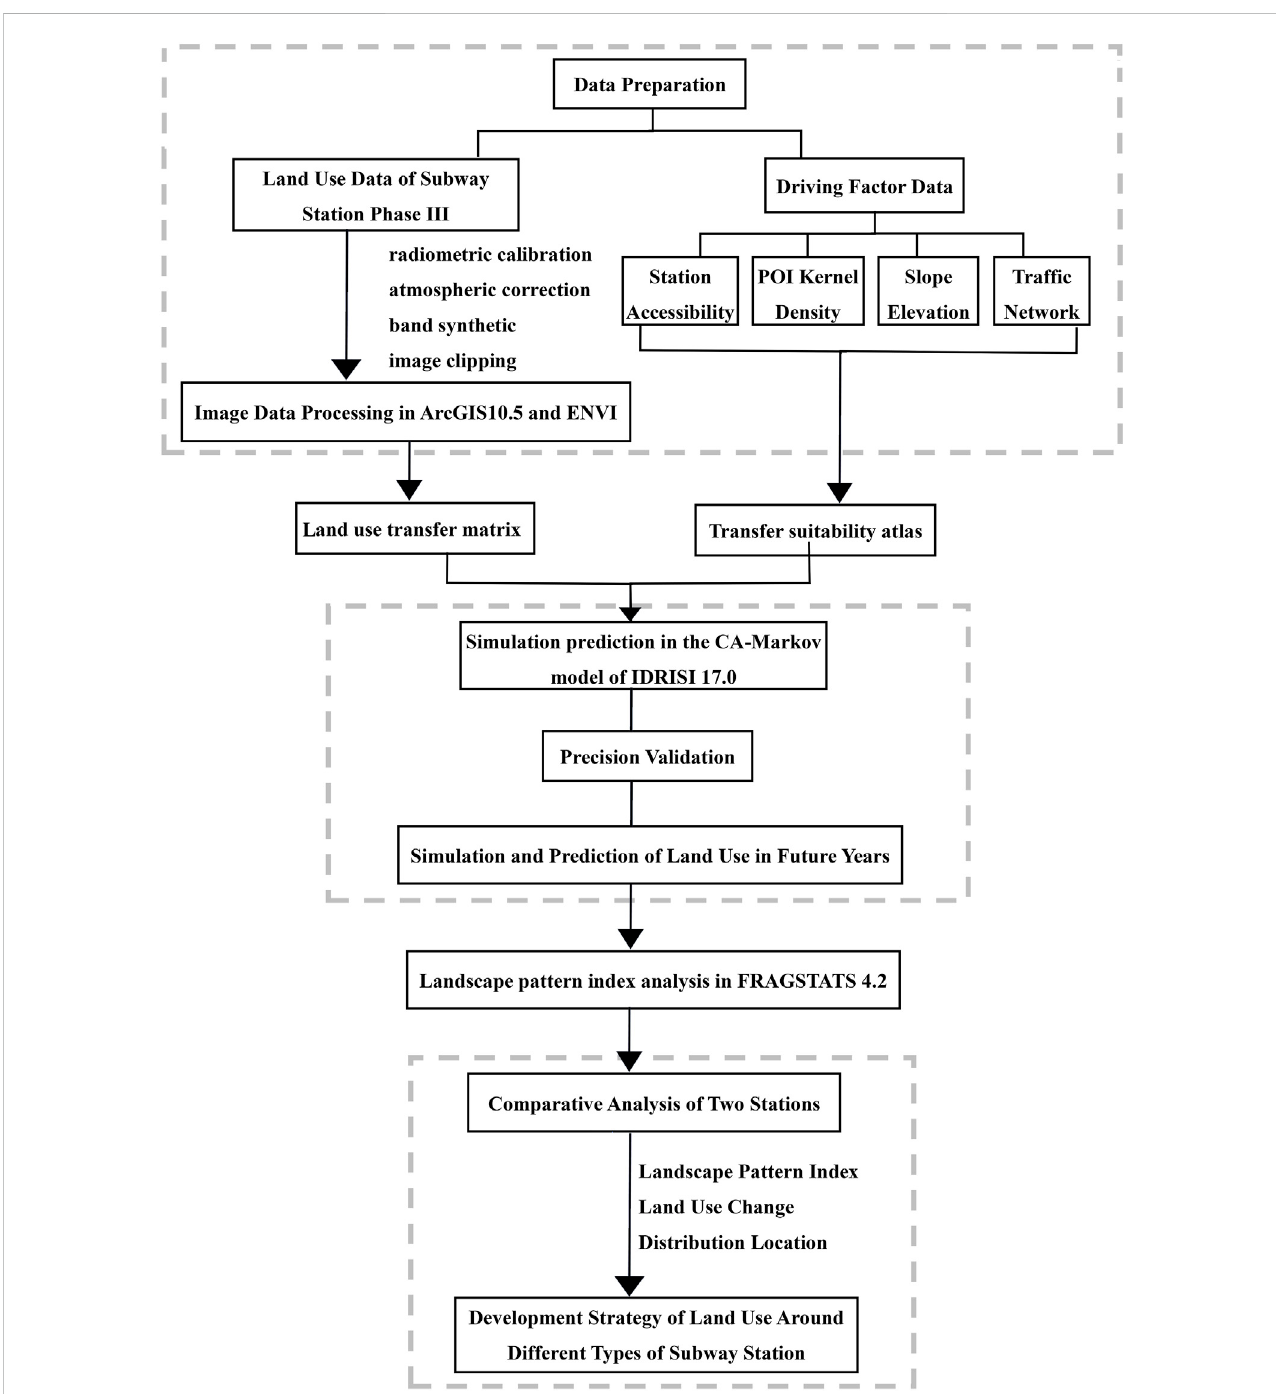
FIGURE 2 TechnicalRoute.First,basedonthelandusedataoftheplanning,constructionandoperationyearsofthetwostations,thesuitabilityatlasisconstructed by combining the driving factors such as POI kernel density and station accessibility. The CA-Markov model was used to simulate the land use and cover situation in the operation year of the station, and the Kappa coef fi cient was calculated by comparing it with the current land use map. After the accuracy veri fi cation, the land use and cover change in the future year were simulated, and the landscape pattern index of the two stations was compared and analyzed. Finally, put forward the development strategy of different types of